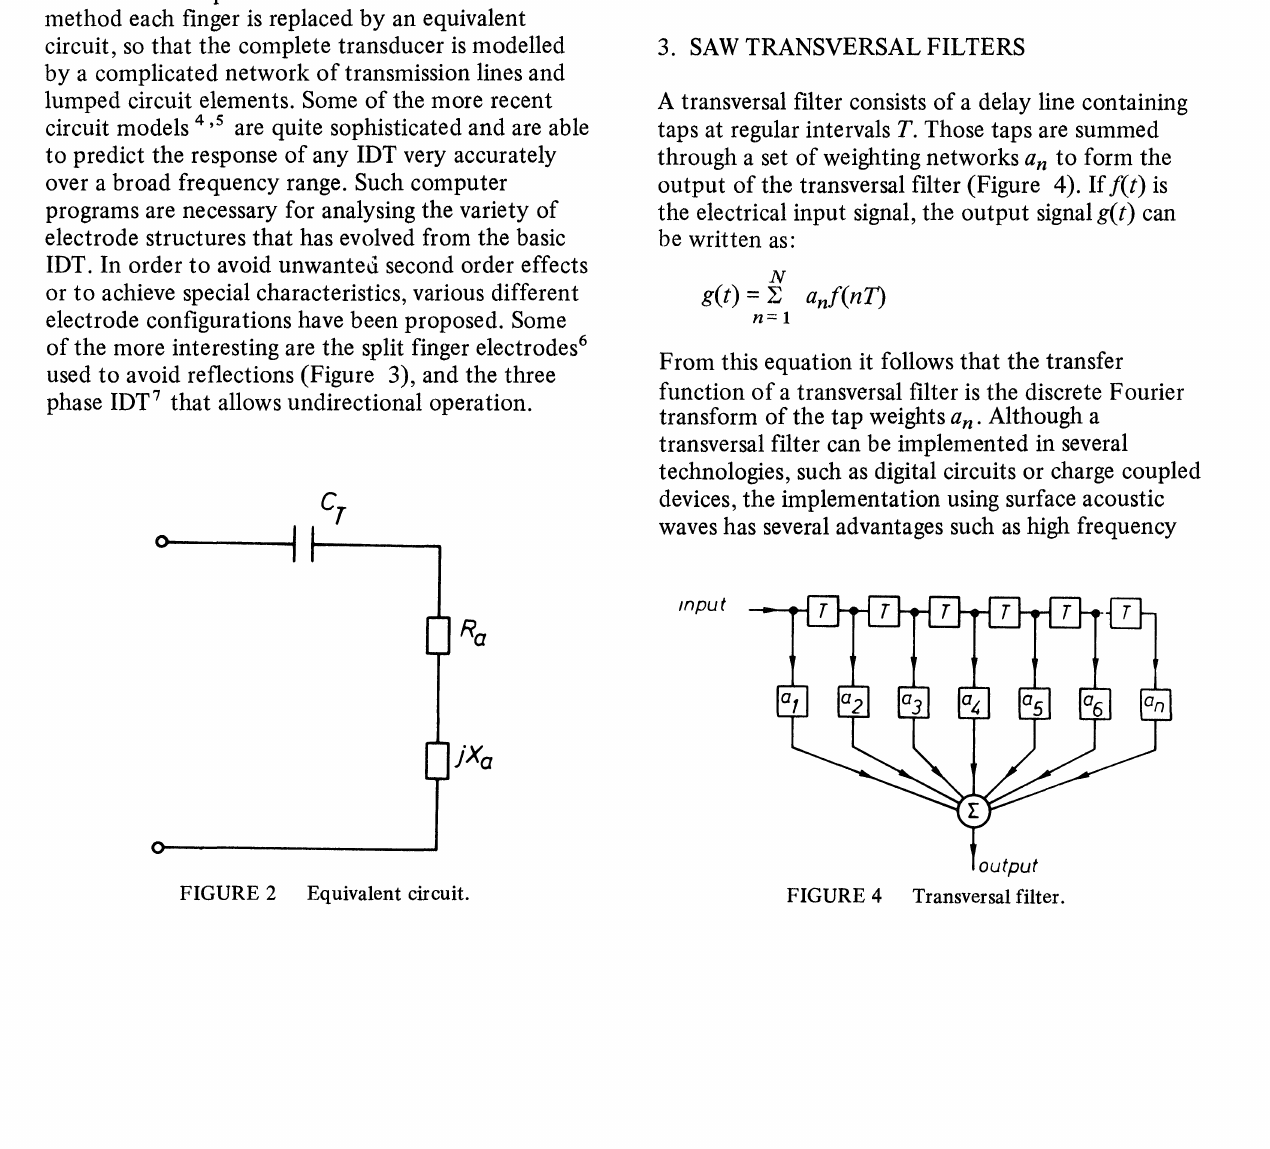
FIGURE 3 Normal IDT and double electrode IDT.